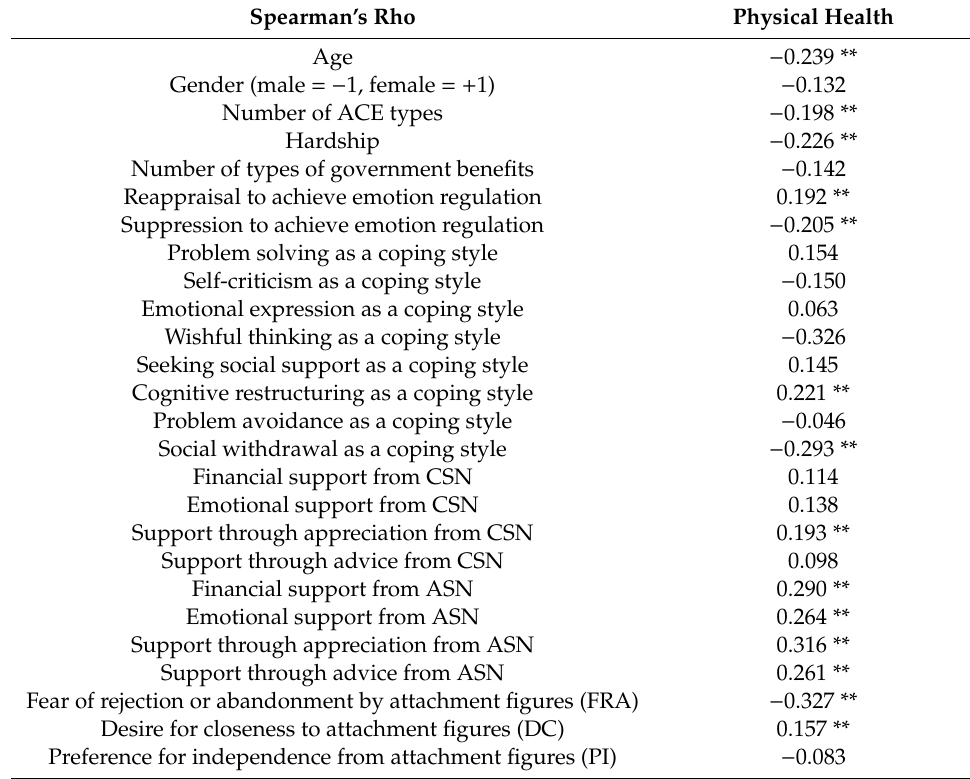
Table 4. Spearman correlations between predictor variables and physical